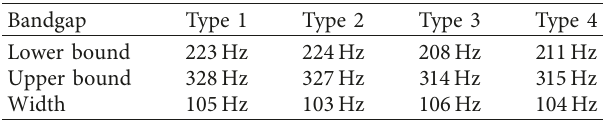
Table 3: Comparison of bandgaps under four geometric configurations.